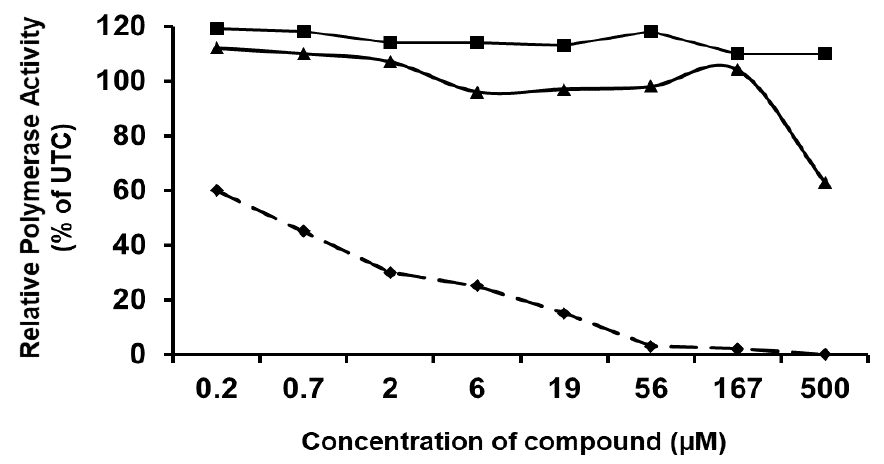
Figure 4. A. Effect of TO502-2403 (CSFCII) (filled triangles), TO505-6180 (CSFCI) (filled squares), and 3 ′ -dGTP (filled diamonds) on the activity of the purified BVDV RdRp, using poly(C) as a template. Data are from a typical experiment are expressed as a percentage of the untreated control.